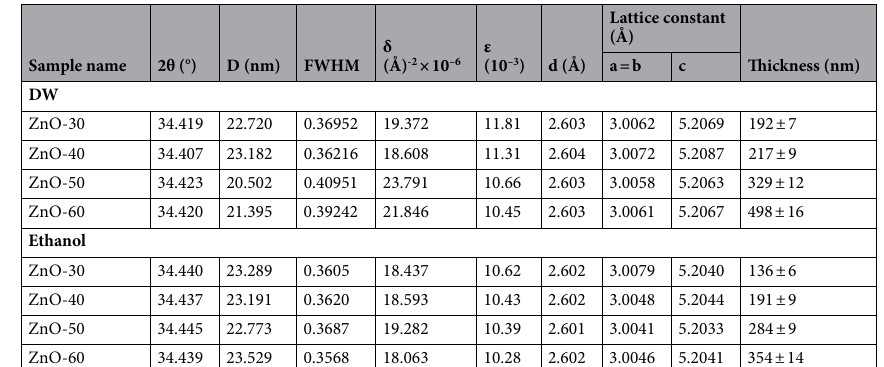
Table 1. Influence of SILAR cycles number on the crystallite size (D), FWHM, dislocation density (δ), lattice strain (ε), interplanar distance (d) and lattice constants (a = b and c) of ZnO films along diffraction peak (002).